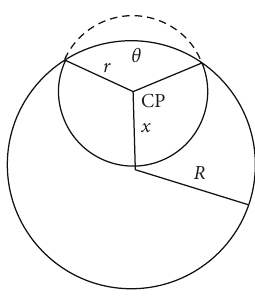
Figure 12: Node CP is shown at distance x from the centre of the disk. Other nodes at distance r are on the ring r + dr centred at CP. The part of the ring outside the disk depicted with the dashed line corresponds to the angle θ